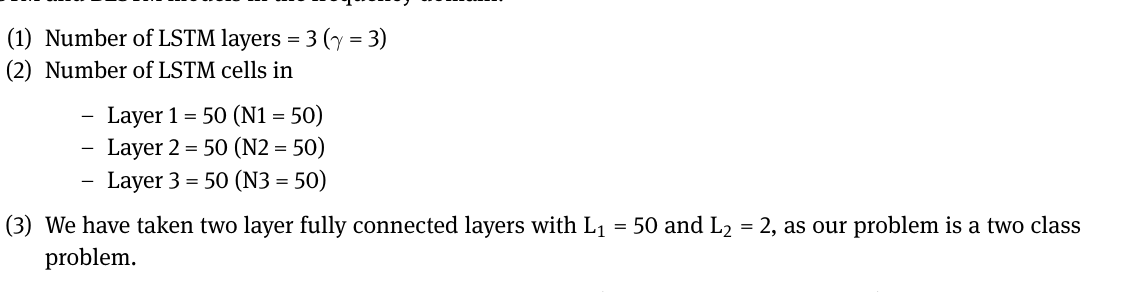
amplitude levels against to the frequency range 1hz - 50hz. The following changes are made for proposed LSTM and BLSTM models in the frequency domain.